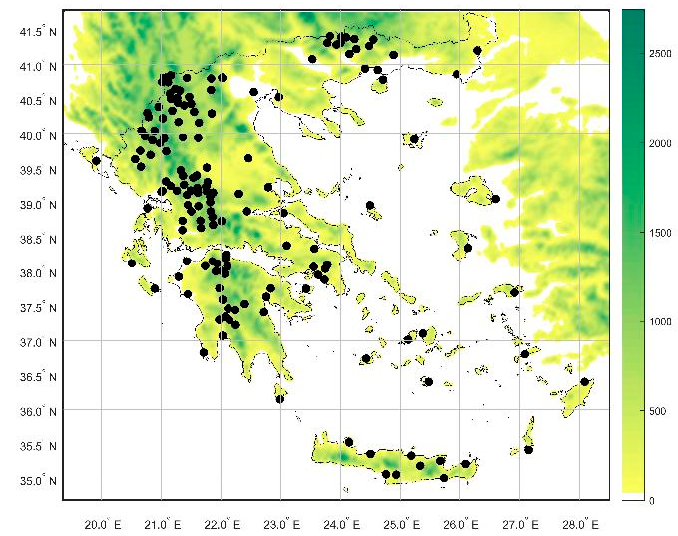
Figure 1. Location of meteorological stations used in the study (black dots).